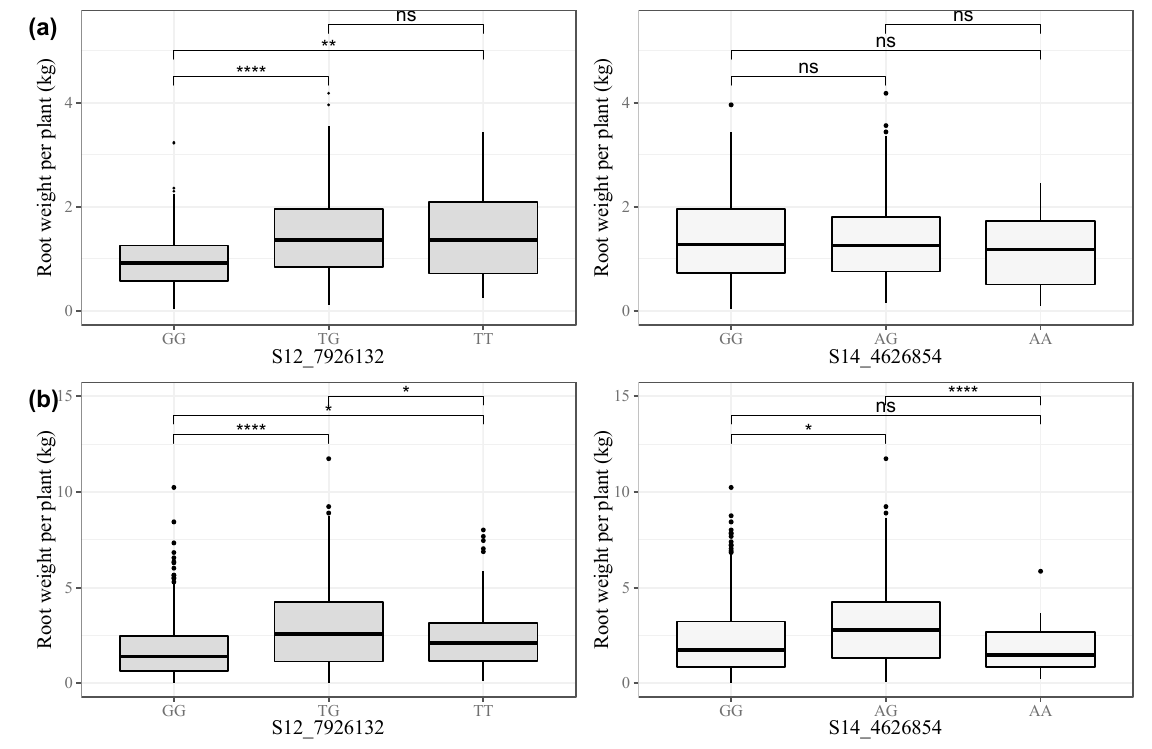
Figure 4. Effects of marker alleles linked to CMD resistance on root weight per plant in the CET stage of the ( a ) breeding and ( b ) prebreeding populations. **** indicates p < 0.0001, *** indicates p <0.001, ** indicates p <0.01, * indicates p <0.05, ns = not significant. Table 5. Accuracy and area under curve values for training and testing sets in the breeding and prebreeding populations.